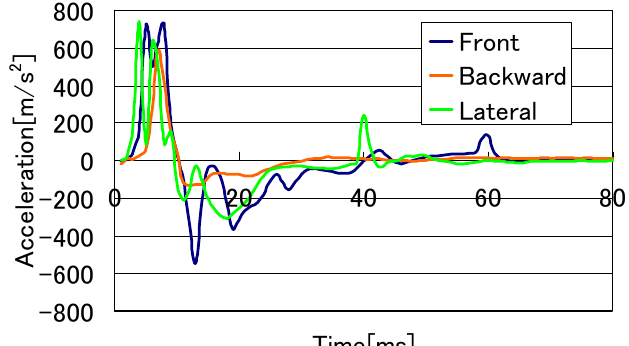
Fig. 5 Acceleration–time responses for impacts at 15.2 [km/h] for each impact direction.